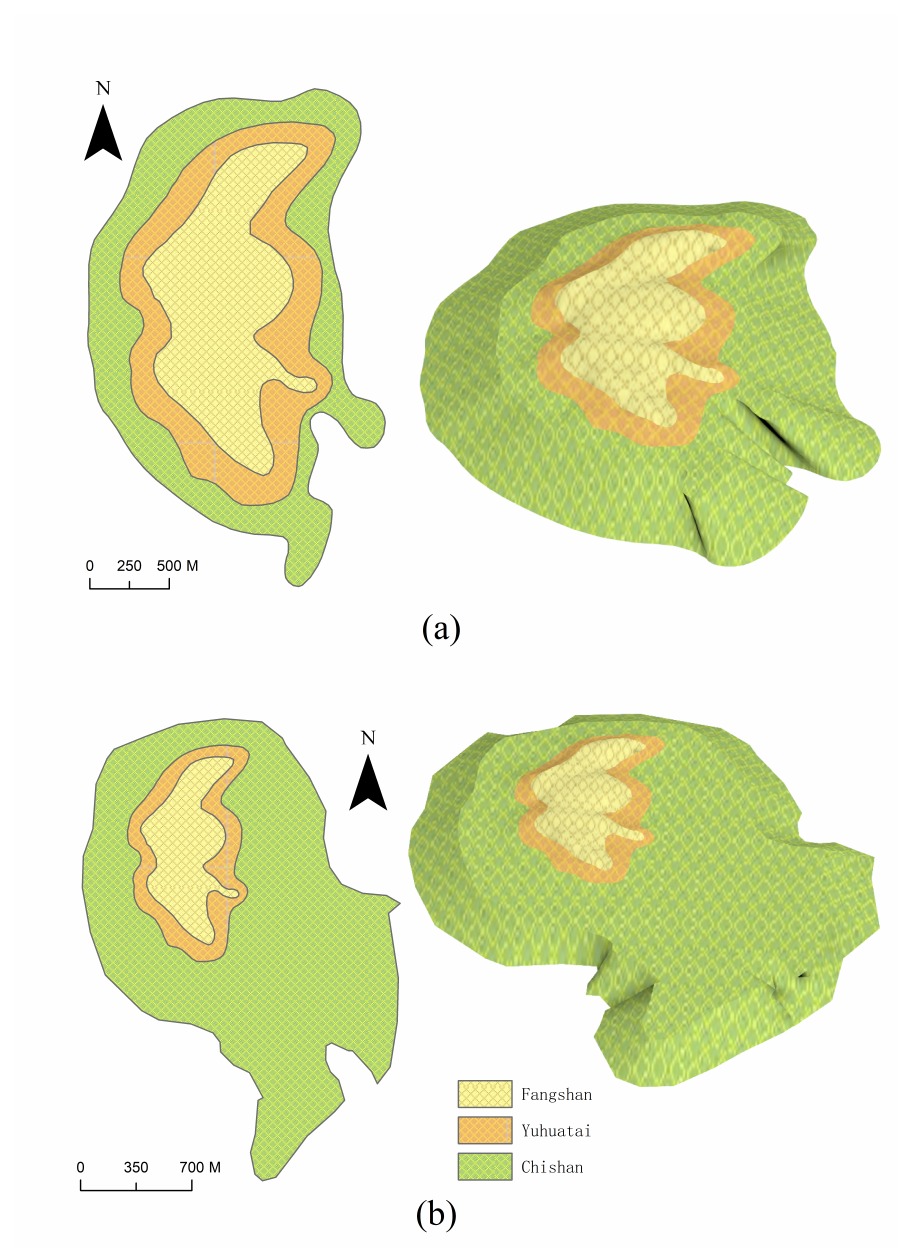
Figure 21. The model of Lingyanshan dome: ( a ) Lingyanshan modeling based on regional geological map; ( b ) Lingyanshan modeling based on bedrock geological